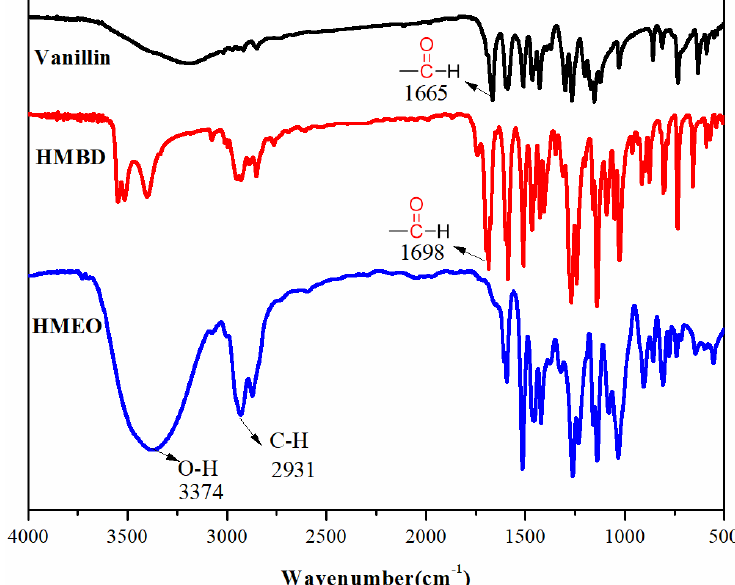
Figure 1. FTIR spectra of vanillin 4-(2-hydroxyethoxy)-3-methoxybenzaldehyde (HMBD) and 2-(4- (hydroxymethyl)-2-methoxyphenoxy) ethan-1-ol (HMEO).